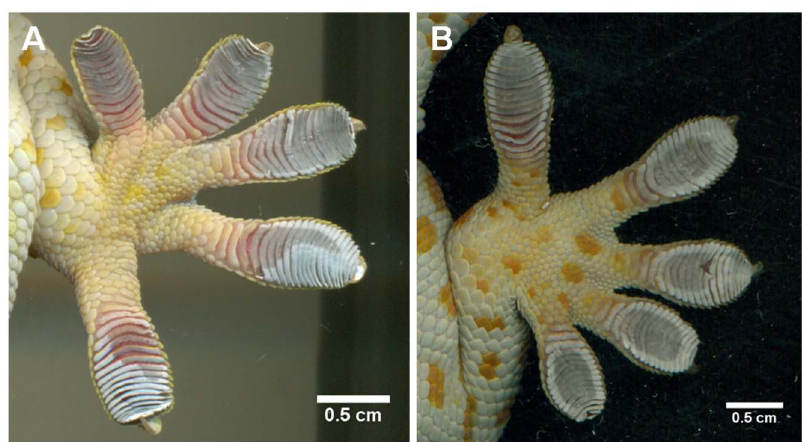
Figure 4. Tokay gecko ( Gekkogecko ) active and passive toe pad drying patterns. Appearance of toe pads at 15 min post-soak in non- stepping (A) and stepping (B) groups. Areas that are grey in color are wet and areas that are white in color are dry. Without stepping toes heterogeneously dry, where some toes are wet and others show an irregular evaporation line (A). Conversely, when allowed to actively step toes dry in a more homogenous fashion, where the outside of the toe dries first, leaving a wet patch (grey in color) in the center of each of the toes (B).